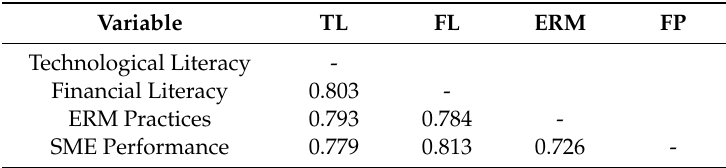
Table 5. Discriminant validity—Heterotrait–Monotrait ratio.